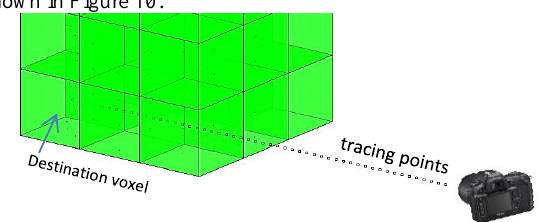
Figure 10. Line tracing with voxels